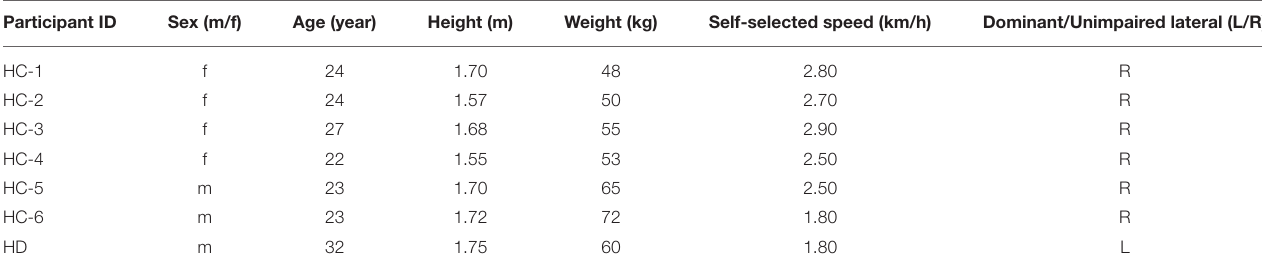
TABLE 1 | Personal information of